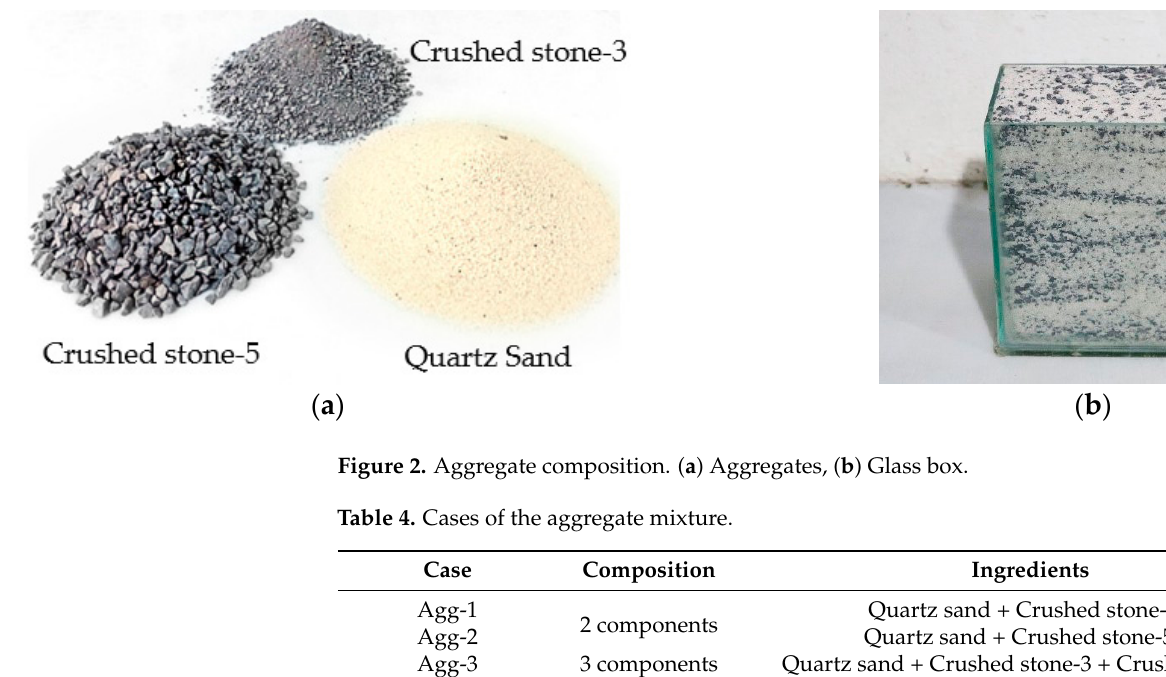
Table 3. Content of aggregate particles passing through the sieve.